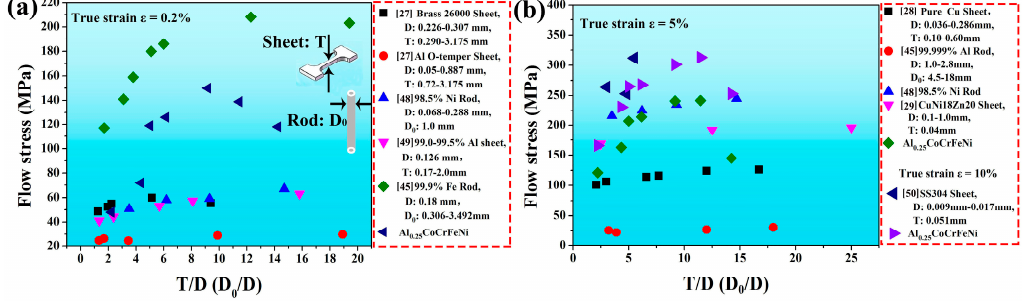
Figure 7. Comparison in the flow stress of traditional metals and Al 0.25 CoCrFeNi with respect to true strain 0.2% ( a ) and 5% ( b ).